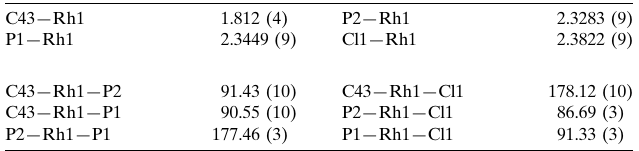
Selected geometric parameters (A˚ , (cid:2) ).